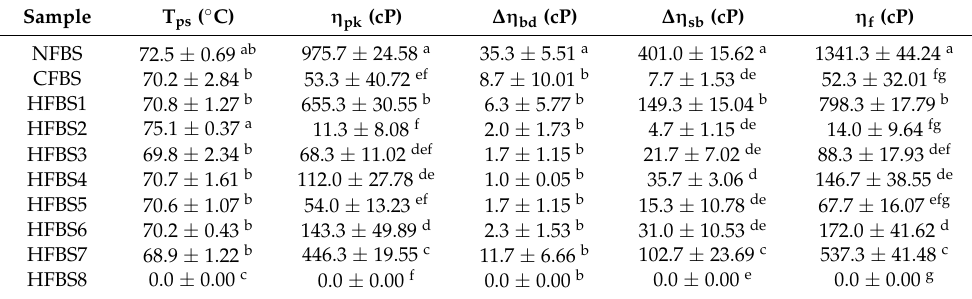
Table 2. Pasting parameters of native and hydrolyzed faba bean starches 1